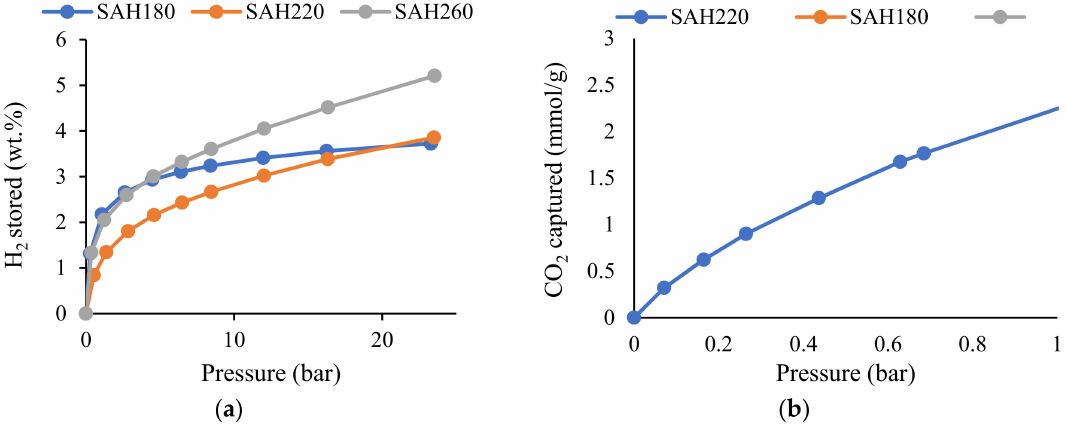
Figure 4. ( a ) H 2 storage isotherms at 77K up to pressure of 23.5 bar. ( b ) Carbon dioxide capture isotherms at 25 ◦ C up to pressure of 1